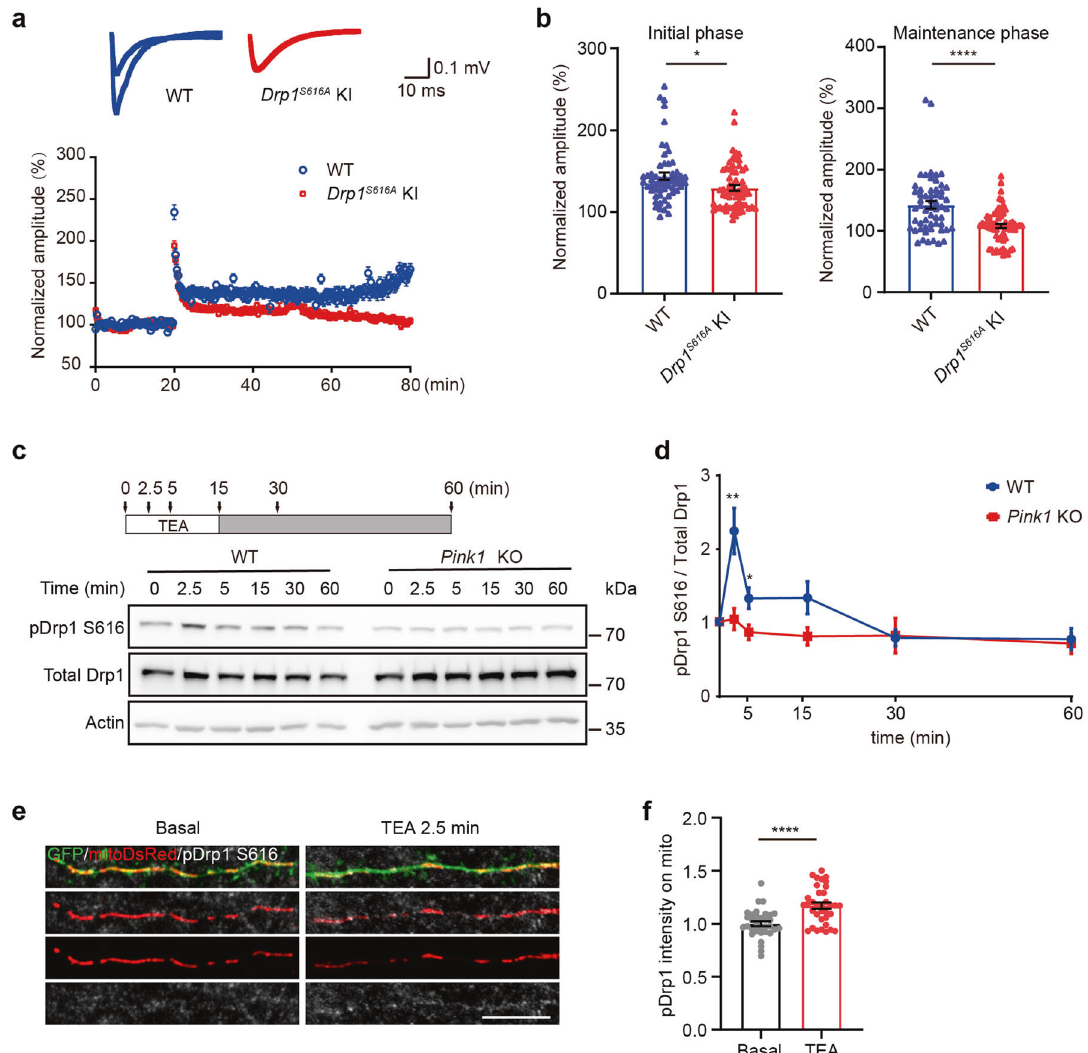
Fig. 5 PINK1-mediated Drp1 S616 phosphorylation is required for LTP induction. a LTP was induced at the Schaffer collateral-CA1 synapses of acute hippocampal slices from 2-month-old WT (blue) and Drp1 S616A KI (red) mice. Amplitudes of the fEPSPs evoked by TBS were normalized to the baseline (de fi ned as 100%). Representative traces are fEPSPs at the basal line and 55 min after TBS. b Quantitation of induced fEPSPs at initial (0 – 10 min after TBS) and maintenance phase (40 – 60 min after TBS) of WT (blue) and Drp1 S616A KI (red) mice. n = 57 and 63 recordings of 5 – 6 WT and Drp1 S616A KI mice, respectively. * P < 0.05, **** P < 0.0001. Student ’ s t -test. c Cortical neurons (DIV 18) derived from WT or Pink1 KO mice were treated with 25 mM TEA for 2.5, 5, and 15 min (arrows, open bar, upper panel). After 15 min treatment, TEA was washed, neurons were harvested at the indicated time (arrows, fi lled bar, upper panel). Levels of phosphor-Drp1 S616 (pDrp1 S616), total Drp1, and actin were shown (lower panel). d Quantitative analysis of phosphor-Drp1 S616 normalized with total Drp1 for experiments presented in c . WT: blue. Pink1 KO: red. n = 7 – 12 treatment. * P < 0.05, ** P < 0.01. Multiple t -test. e Cortical neurons (DIV 10) derived from WT mice were expressing mitoDsRed (red) and GFP (green). At DIV 18, neurons were treated with either solvent (Basal) or 25 mM TEA for 2.5 min, fi xed, and stained with anti- pDrp1 S616 antibody (gray). Representative images of pDrp1 S616 and mitochondria were shown. Bar = 10 μ m. f Quantitation of pDrp1 S616 intensity on mitochondria. Mitochondria were reconstructed by Imaris. The mean intensity of pDrp1S616 on mitochondria was calculated. Data were normalized with the mean value of pDrp1 S616 intensity of the Basal group in the experiment. n = 34 and 35 dendrites from Basal and TEA group of three independent experiments. **** P < 0.0001. Student ’ s t